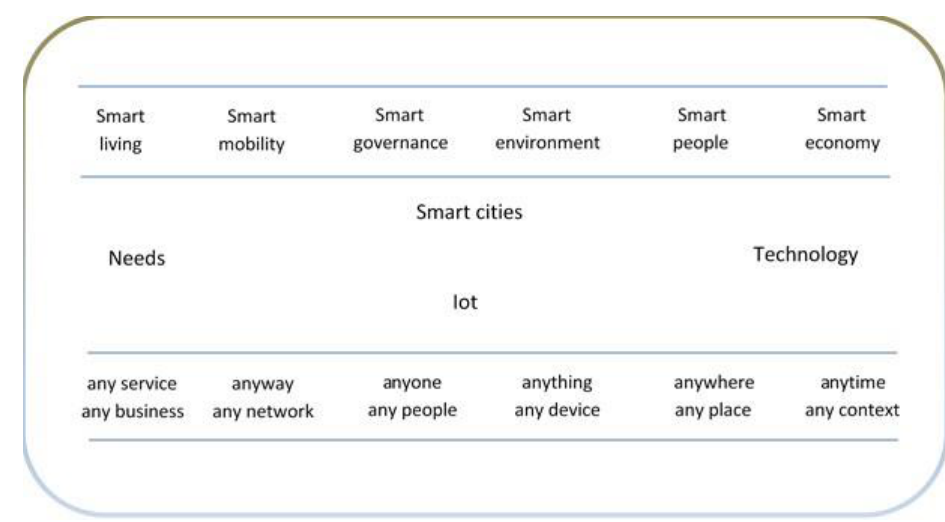
Figure 3. An expanded potential for new business models.